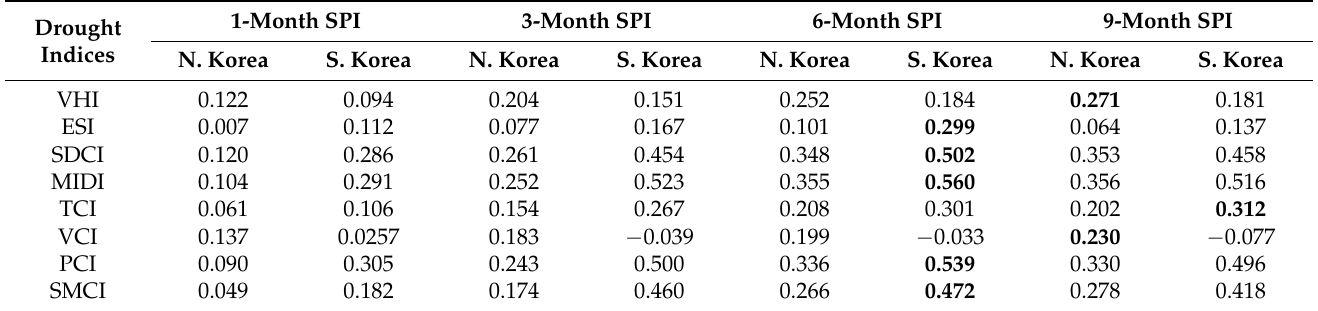
Table 2. Comparison of the correlation coefficients between various drought indices and station-based meteorological drought index (SPI). The highest correlation coefficient for each index is shown in